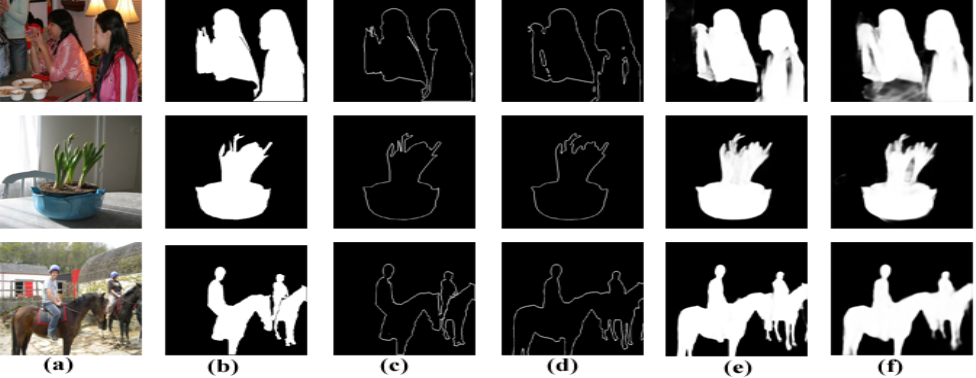
Figure 10. Saliency maps with and without contour-based supervision: ( a ) input Image, ( b ) ground- truth, ( c ) contour-based ground-truth, and ( d – f ) are the contour, saliency, and joint-supervision saliency maps generated by the CSRU,